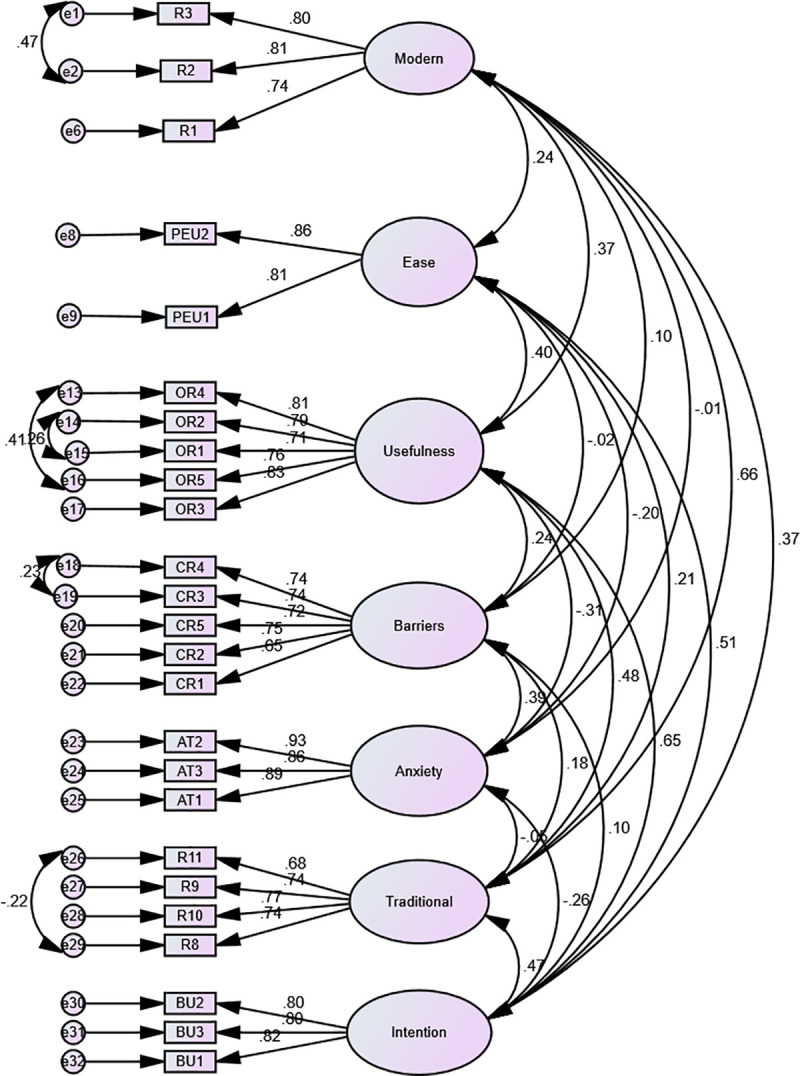
CFA (1) model that reproduces relationships among theoretical constructs.Study case on the overall sample (N = 572).